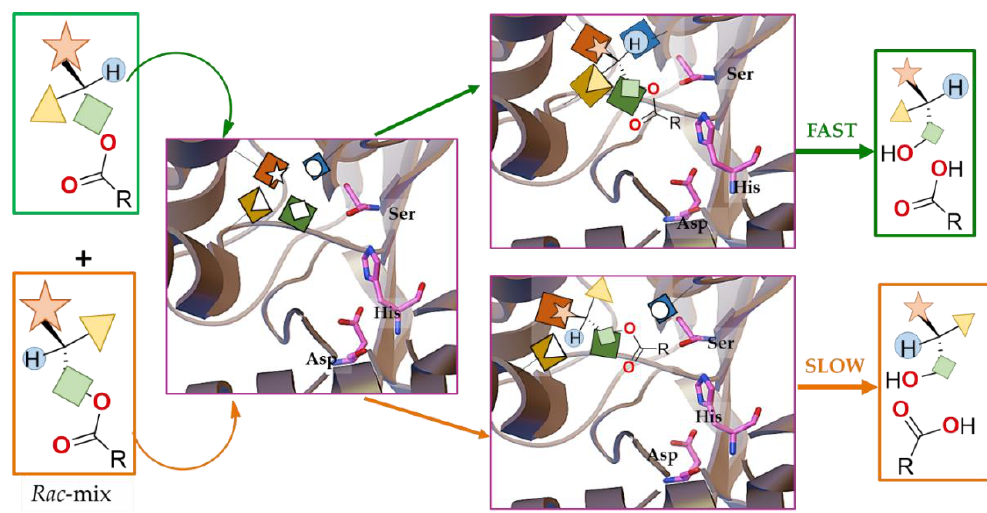
Figure 5. Representation of the “Mirror-Image Packing”: enantiomer recognition by enzymes relies on interactions between the substituents at the stereocenter and the recognition site. For a racemic mixture when the substrate has a stereocenter with -H as a substituent and is close to the carbonyl C, there will be a preference of reactivity to one enantiomer over another. For the enantiomer that react fast (green) all four interactions match, on the other hand, for the slow-reacting enantiomer (orange), only two substituents match (orange and green boxes) when all the substituents point to the interaction sites. Adapted from [117].